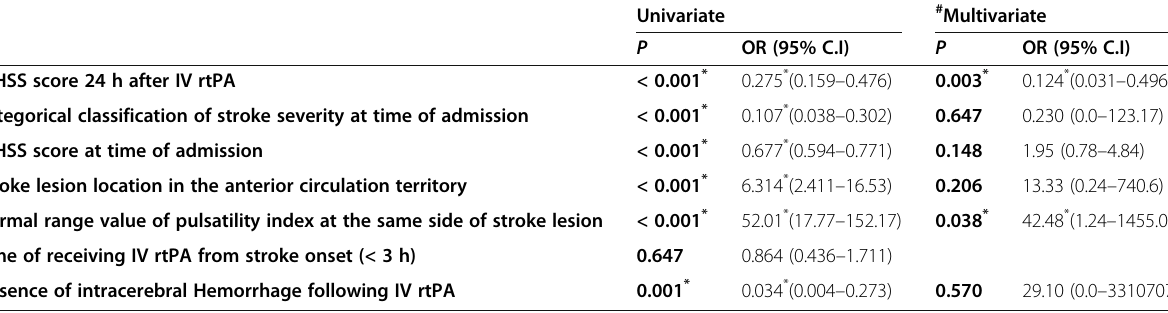
Table 6 Univariate and multivariate analysis between study variable (stroke illness and intracerebral hemorrhage following IV rtPA) and good functional outcome